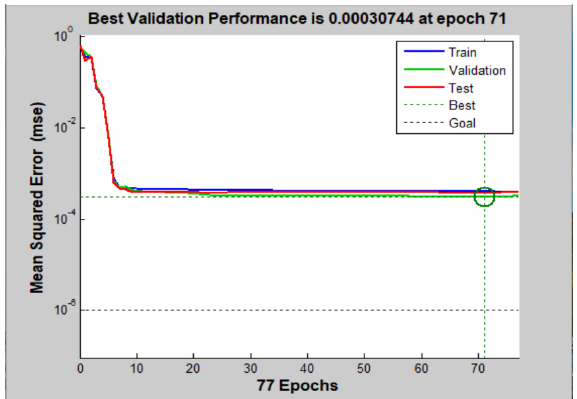
Figure 6. Training iterations of GSA-BP neural network.